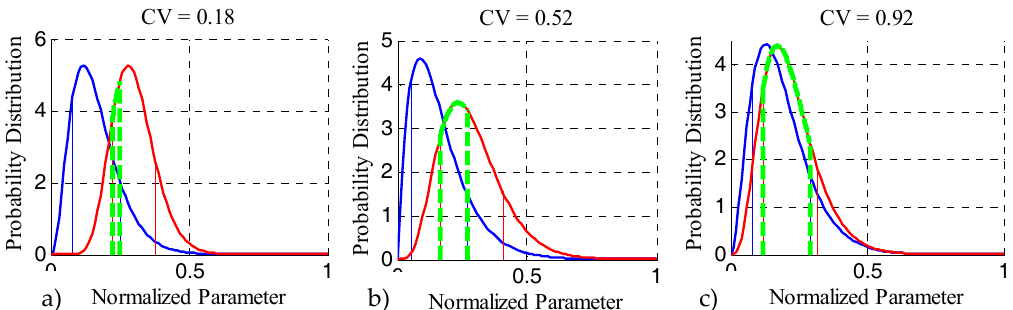
Figure 2. Examples of the metrics calculated within one time window: ( a ) two significantly different distributions yielding a CV of close to 0.2; ( b ) two distributions yielding a CV of around 0.5; ( c ) two very similar distributions yielding a CV of close to 1 [25]. Red curve shows the distribution of the selected machine and blue curve shows the distribution of its peers. Green line shows the selected area for calculating the CV .